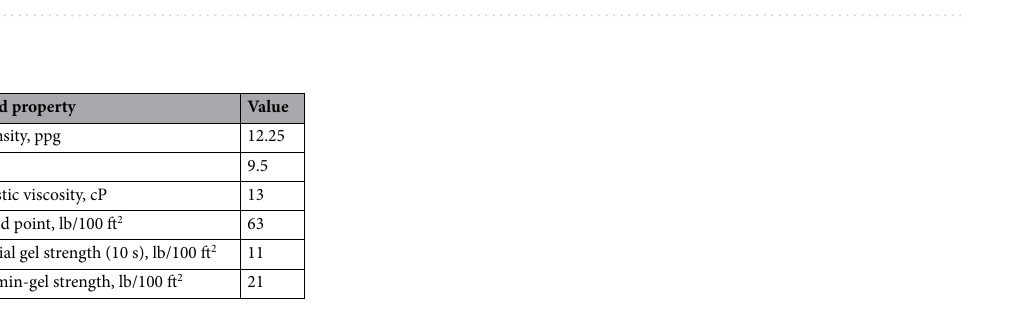
Table 2. WBM rheological properties measurements at 80